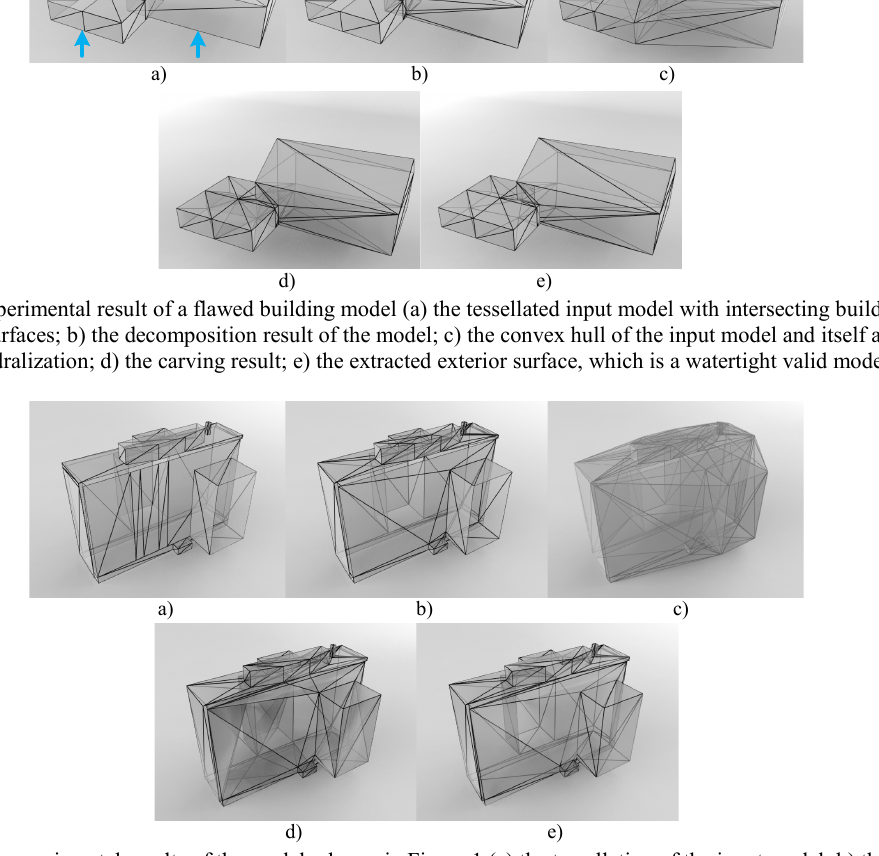
Figure 12. The experimental results of the models shown in Figure 1 (a) the tessellation of the input model; b) the result of decomposition and coplanar triangle merge; c) the initial approximation; d) the result after heuristic carving, with boundary tetrahedra visible; e) the final exterior surface extracted from